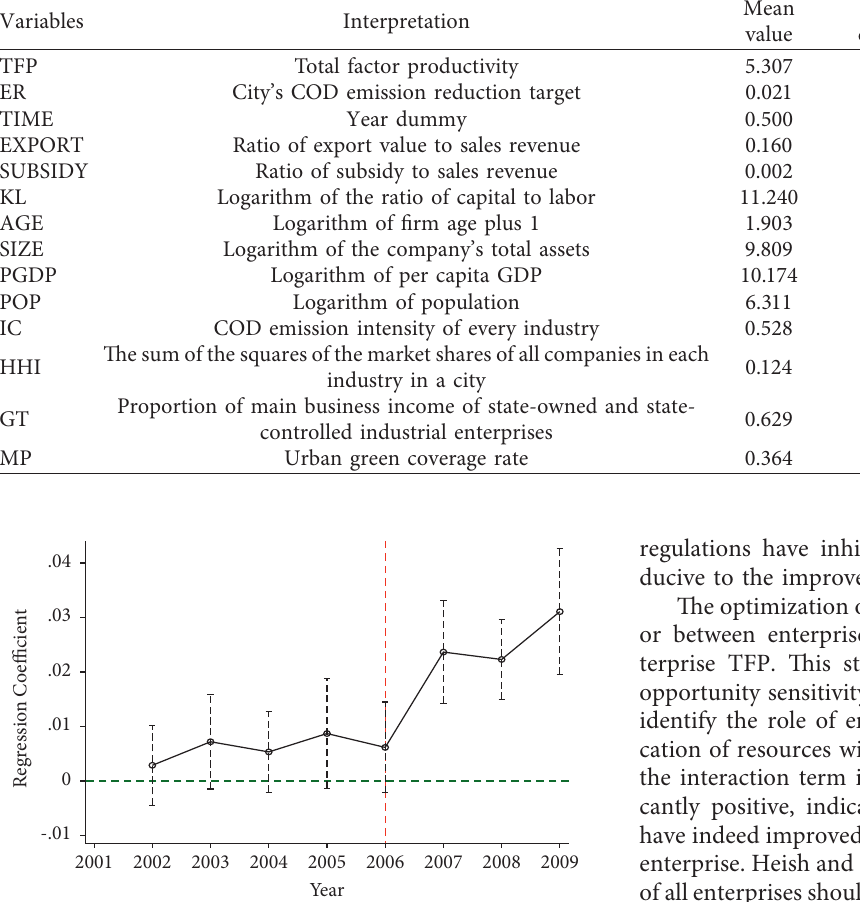
Figure 1: Dynamics of COD emission reduction targets. Note: the figure plots the estimated coefficients of the city’s environmental regulation and year dummy. The reference year is